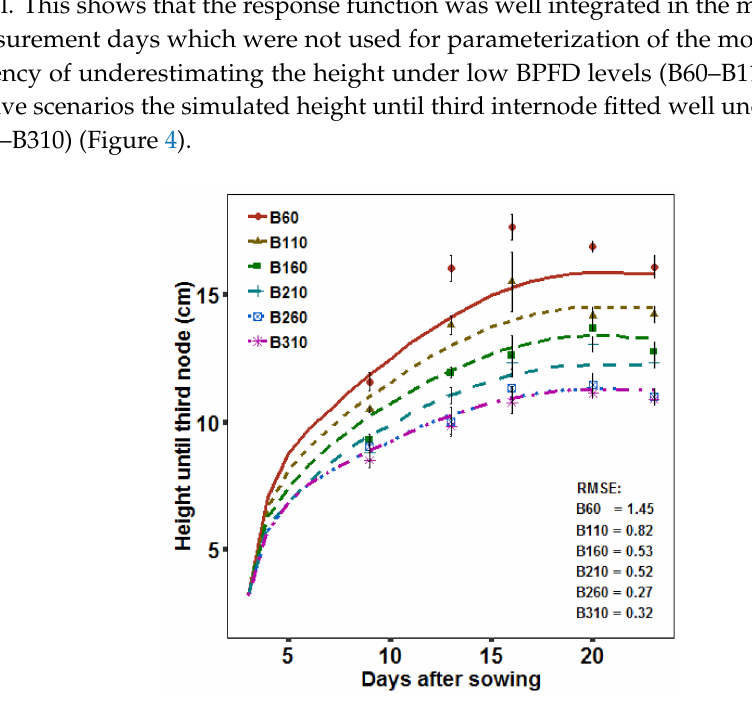
Figure 4. Simulated (line) and measured (points) plant height until the third node and root mean square error (RMSE) between simulations and measurements. Error bars indicate standard error of the mean (day 9–20: n = 4, day 23: n =